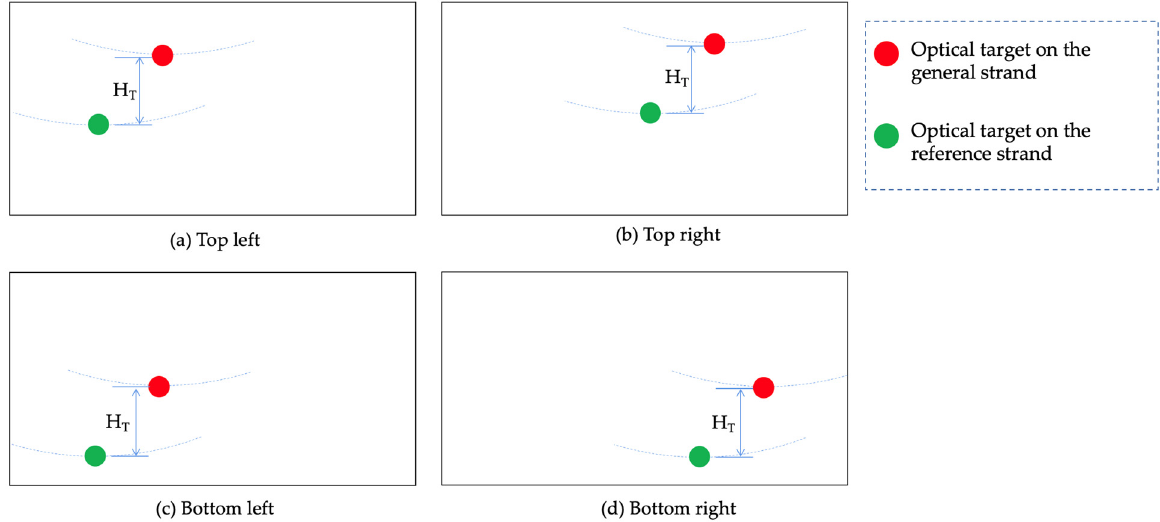
10 of 19 Figure 11. Schematic diagram of image deflection caused by camera deflection.